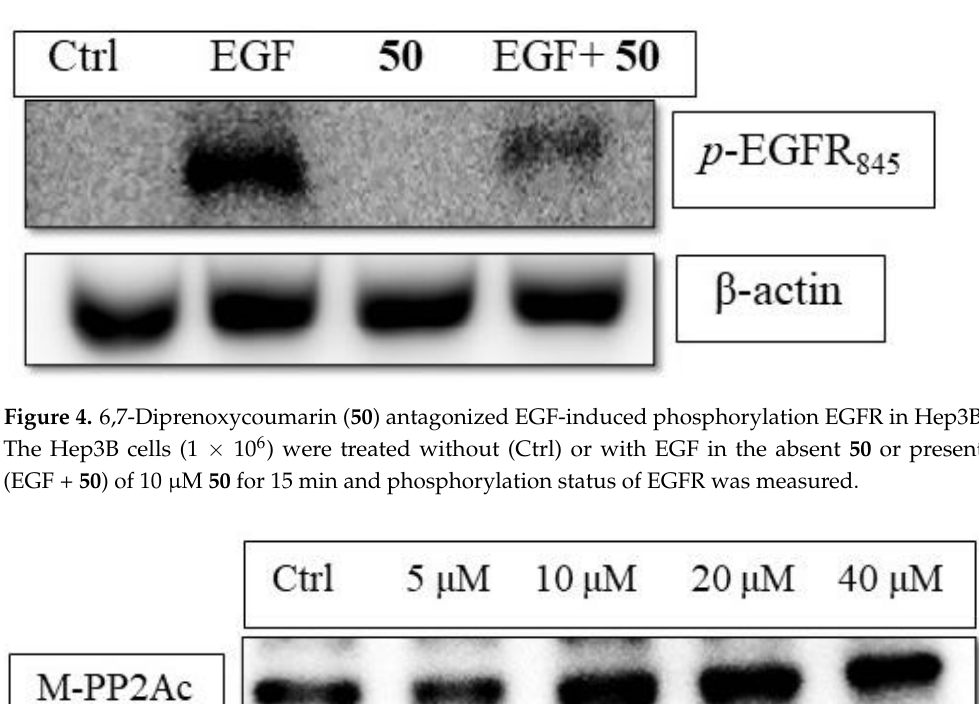
Figure 6. The time course study of mRNA expression of MRP2 and UGT1A1 after 10 μM 6,7-di- prenoxycoumarin treatment. Hep3B cells were treated with 10 μM 50 for 2, 4, 6, 8 and 10 h. The total mRNA was obtained and the expression of downstream genes were analyzed with PCR. The ratio of MRP2 to GAPDH was calculated using Image J and normalization.